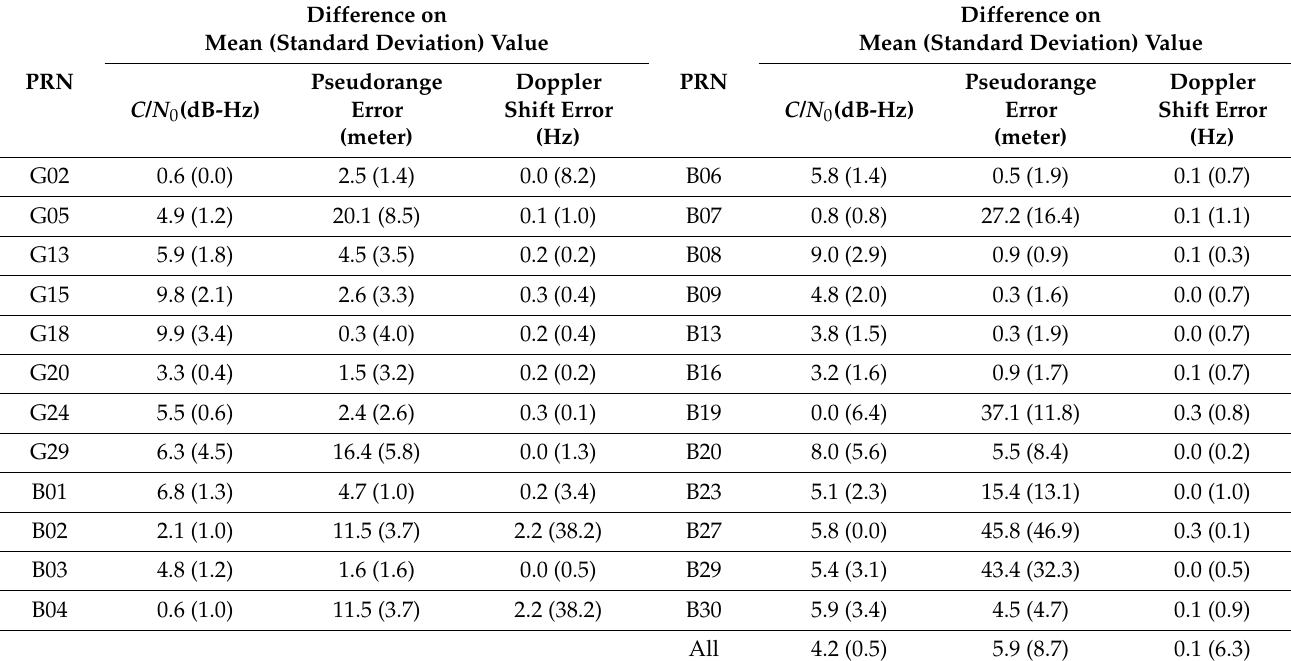
Table 4. The difference in mean value (standard deviation) between simulation and real data.